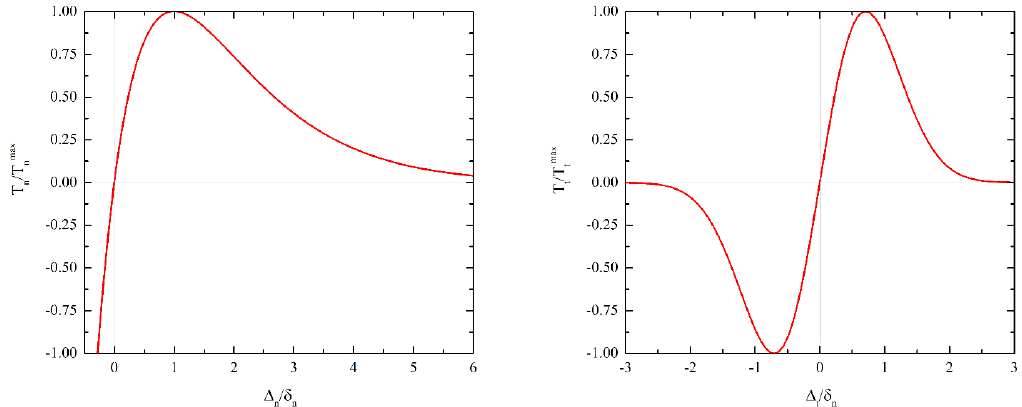
Figure 2. Normalised cohesive laws. Normal traction (left); shear traction and slip (right).